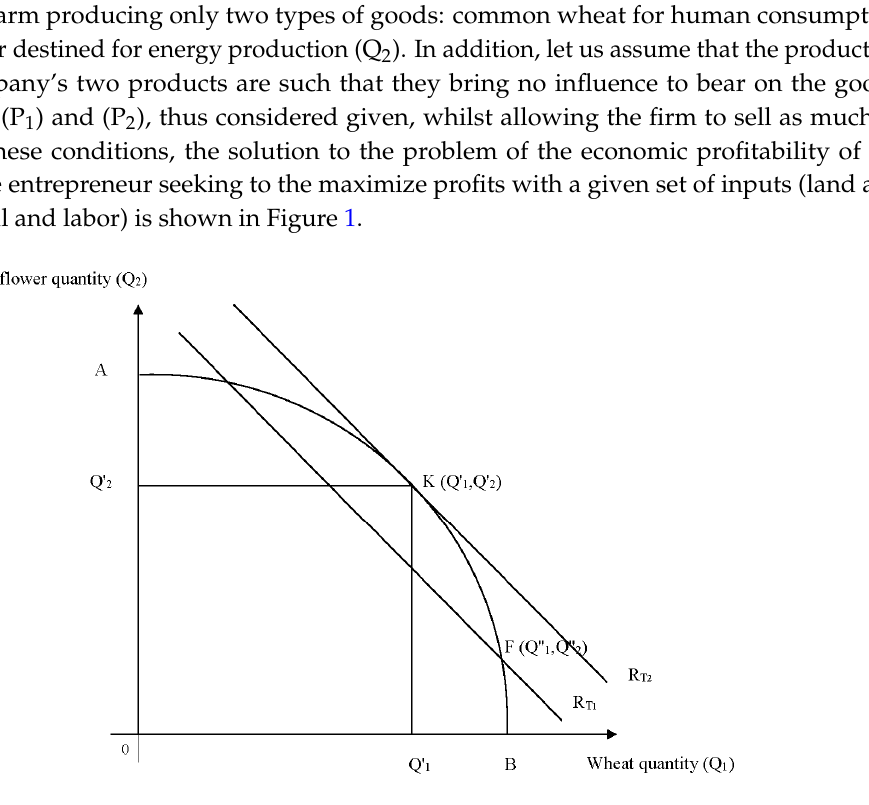
Figure 1. Economic profitability analysis according to production ‐ possibility frontier.